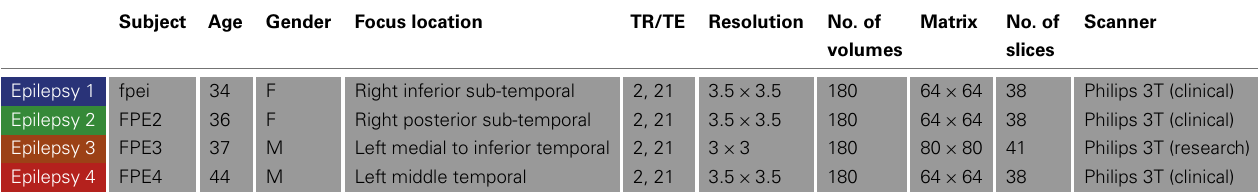
Table 1 | Epilepsy subject demographic information and scanning